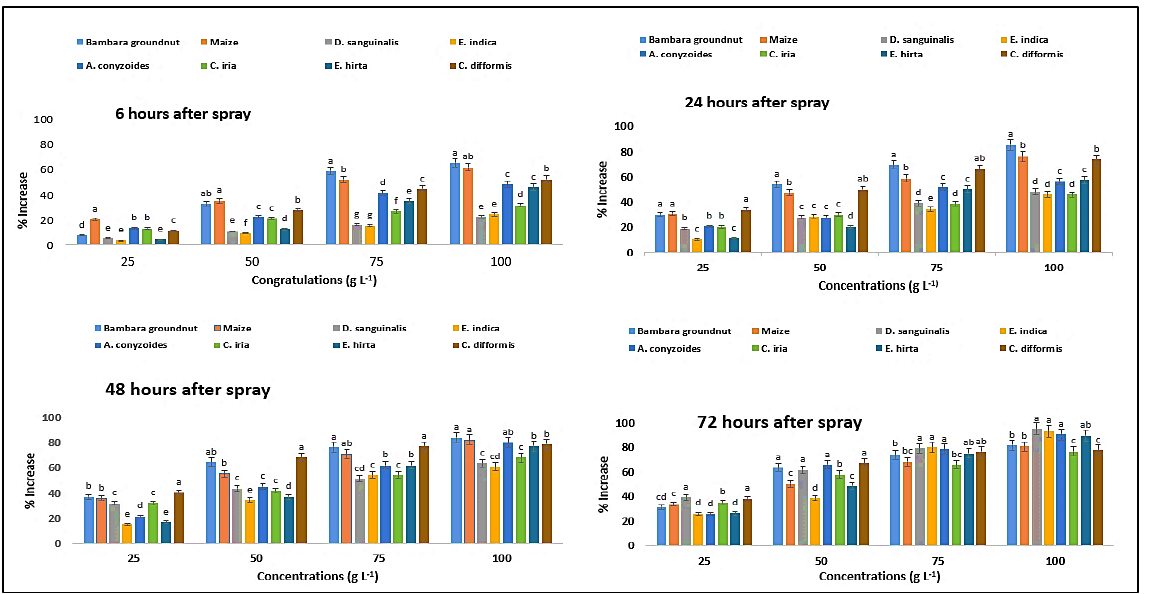
Figure 14. Increase (%) content of SOD in test crops and weeds treated with parthenium leaf methanol extract at different associated times. Values with the same letter among the tested crops and weeds are not significantly different at the same extract concentrations at p ≤ 0.005, by Tukey ’ s HSD. 2.13. Effect on Catalase Content of the Crops and Weeds At varied exposure durations, the activity of catalase (CAT) differed considerably with increasing concentration of P. hysterophorus extract (Table 7). The activity of CAT in Bambara groundnut, maize, D. sanguinalis , E. indica, A. conyzoides, C. iria, E. hirta, and C. difformis was considerably increased by foliar spray of P. hysterophorus extract at different times. In Bambara groundnut, the values were 49, 66, 91, and 87%, but in maize the values were 48, 65, 89, and 85%, measured at 6, 24, 48, and 72 HAS, respectively, with the con- centration of 100 g L −1 (Figure 15).